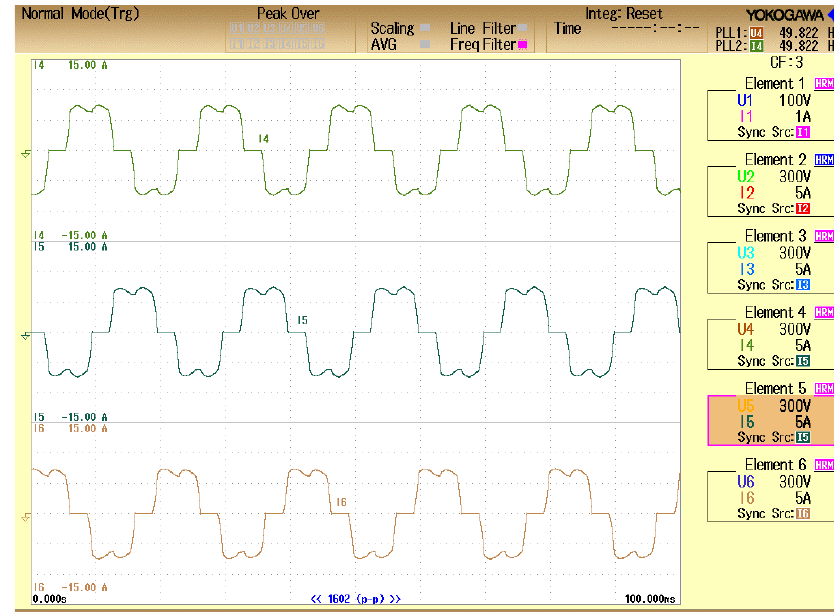
Figure 12. Load currents of three phases.